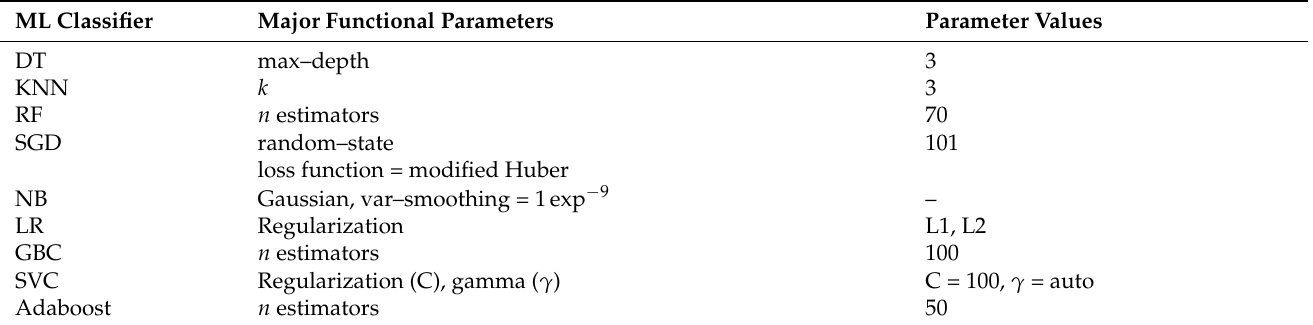
Table 5. Classification Models and their